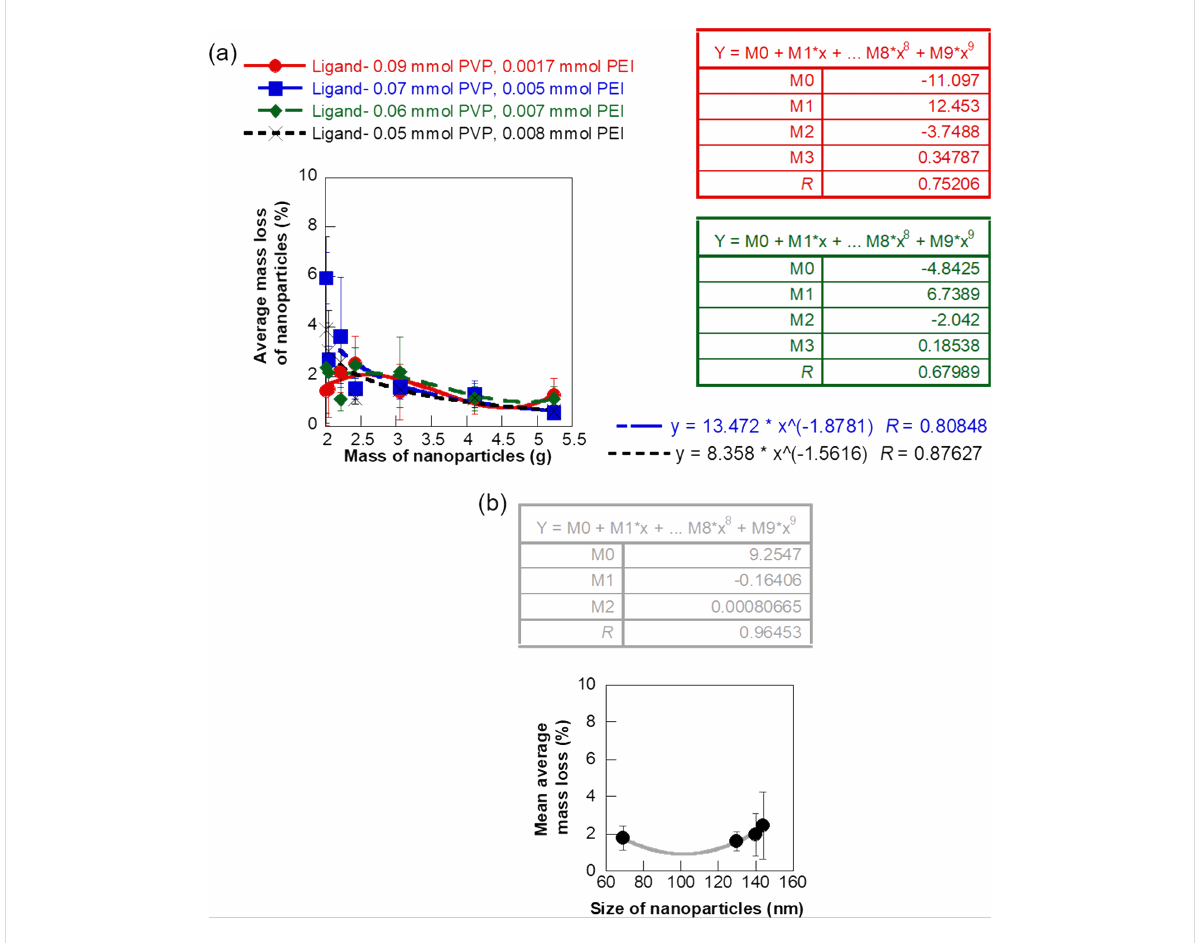
Figure 8: Experimental mass loss of the NPs during flow through hydrogel channels. (a) Plot showing average mass loss at different inlet mass con- centrations of NPs and (b) variation in mass loss of NPs during flow with respect to size of the NPs. The error bars represent standard